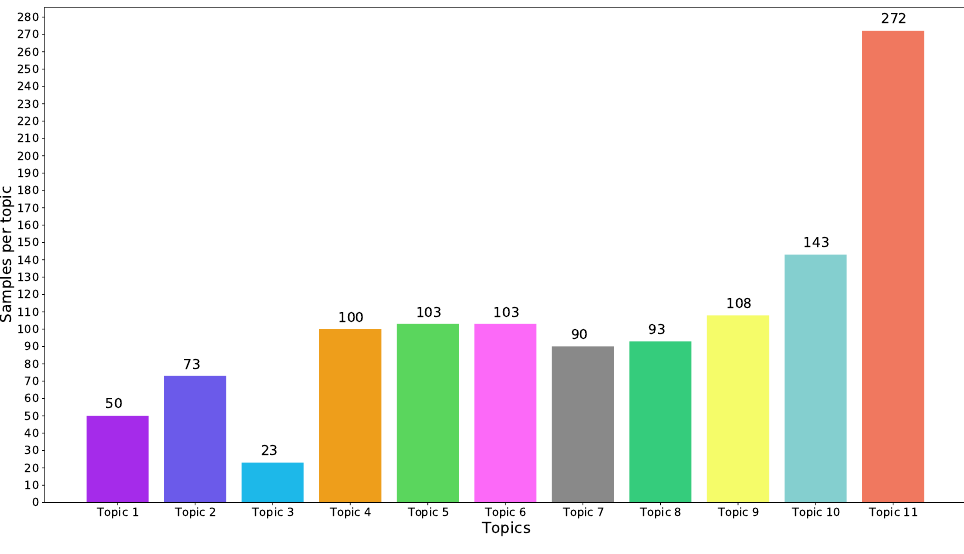
Figure 9. Annotated samples per topic. Table 6. Distribution of the annotated data over Source and Language. Spanish